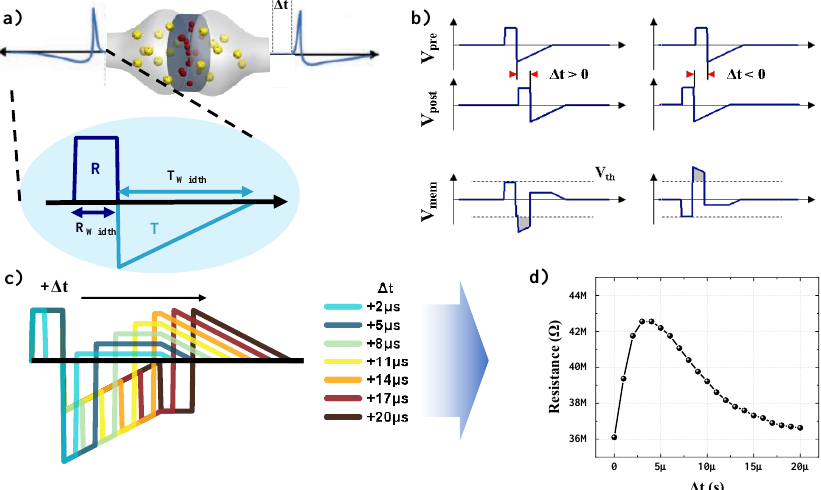
Figure 3. Schematic representation of the imitation of the biological synapse of a memristor device: STDP. ( a ) Concept of STDP measurement for the neuron – synapse – neuron in a memristor device (upper), and the measurement-related spike shape (lower). ( b ) Ideal model of STDP measurement for memristor device. ( c ) Time-dependent properties of programming spikes. ( d ) Resistance state modulation using the STDP learning method.